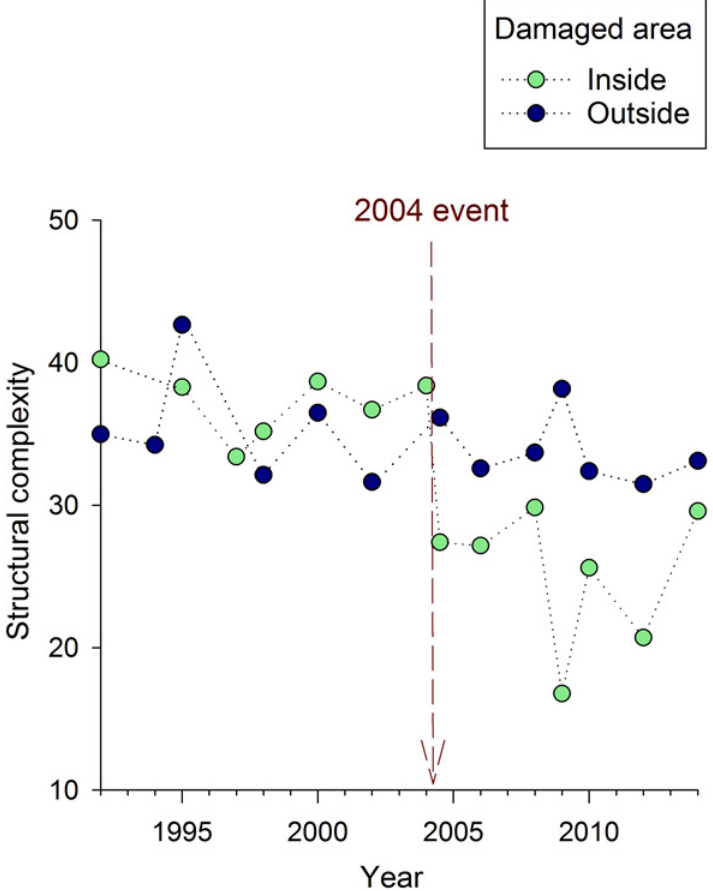
Fig 4. Mean reef structural complexity over time at Crab Cove, showing changes inside and outside the area damaged by the 2004 anchoring event. The dotted vertical line indicates the timing of the 2004 anchoring